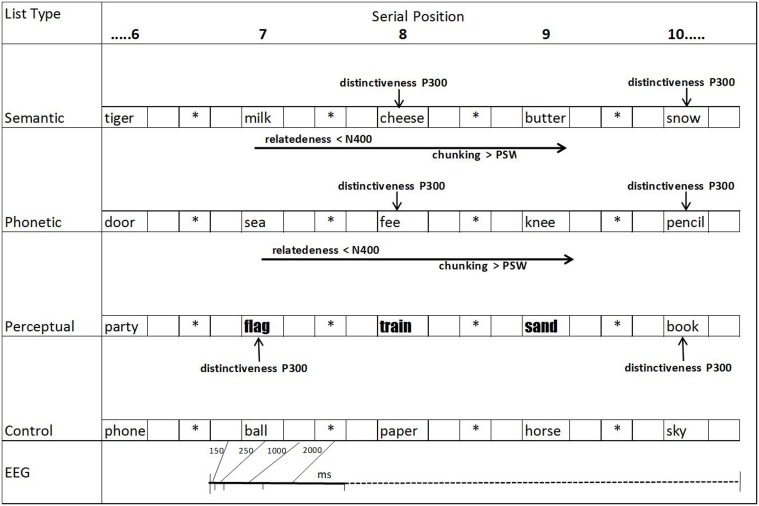
Schematic representation of the presentation of word lists, times when ERPs (EEG) were registered (150 ms before 7th word until 1000 ms after the 10th word; *fixation points; blank spaces, blank screens) and expected deflections based on our hypotheses.